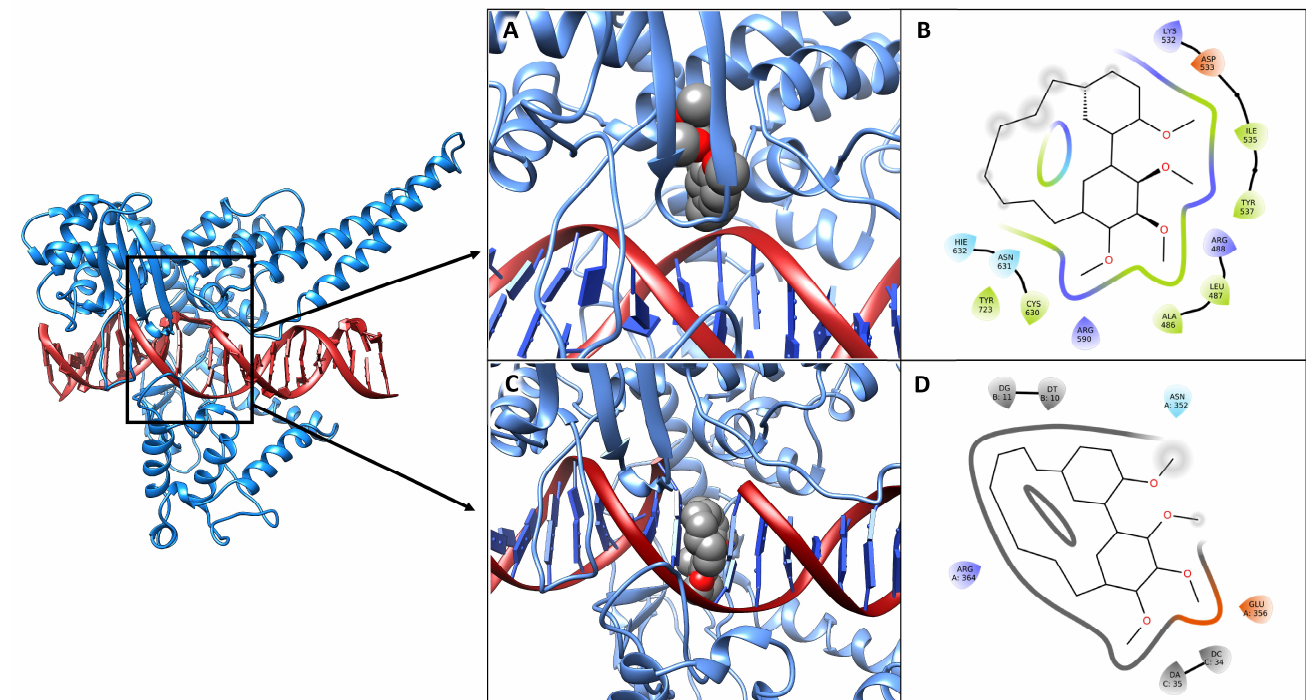
Figure 7. Three-dimensional structure of the hTopI-DNA-drug complexes. The hTop1 structure is represented as a blue cartoon, while the DNA is shown as red ribbons. ( A ) Three-dimensional best binding pose obtained for the drug within the catalytic site. ( C ) Three-dimensional best binding pose obtained for the drug in an intercalated configuration. DM is shown as a space fill model, colored by the atom type, with carbon atoms in grey. The pictures were obtained using Chimera [50]. ( B , D ) Two-dimensional schematic view of the interactions between the drug and the hTop1-DNA complex for the two poses. Labels indicate base or residue names and their numbering in the structure. The pictures were created using the Maestro software (Schrödinger Release 2022-2: Maestro, Schrödinger, LLC, New York, NY, USA, 2021).